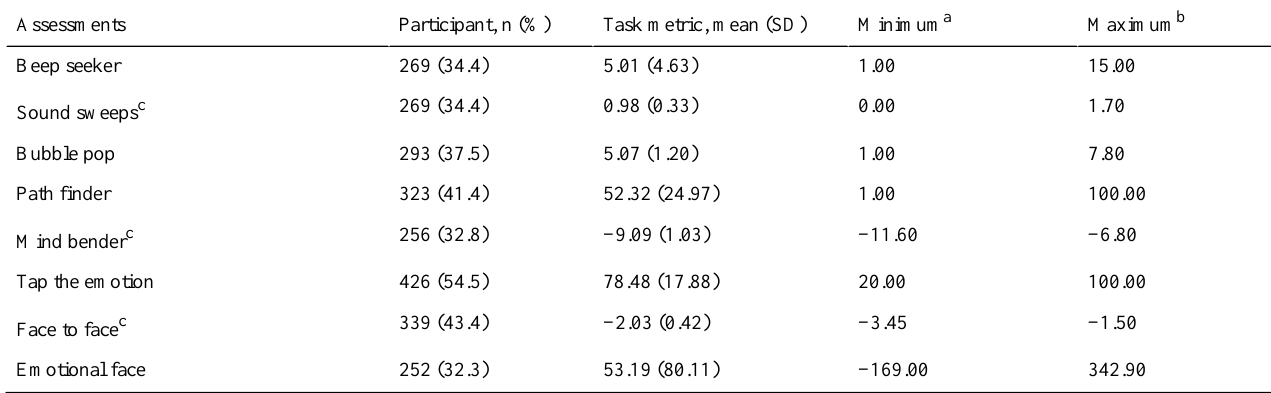
Table 2. Normative statistics by online neurocognitive assessment.